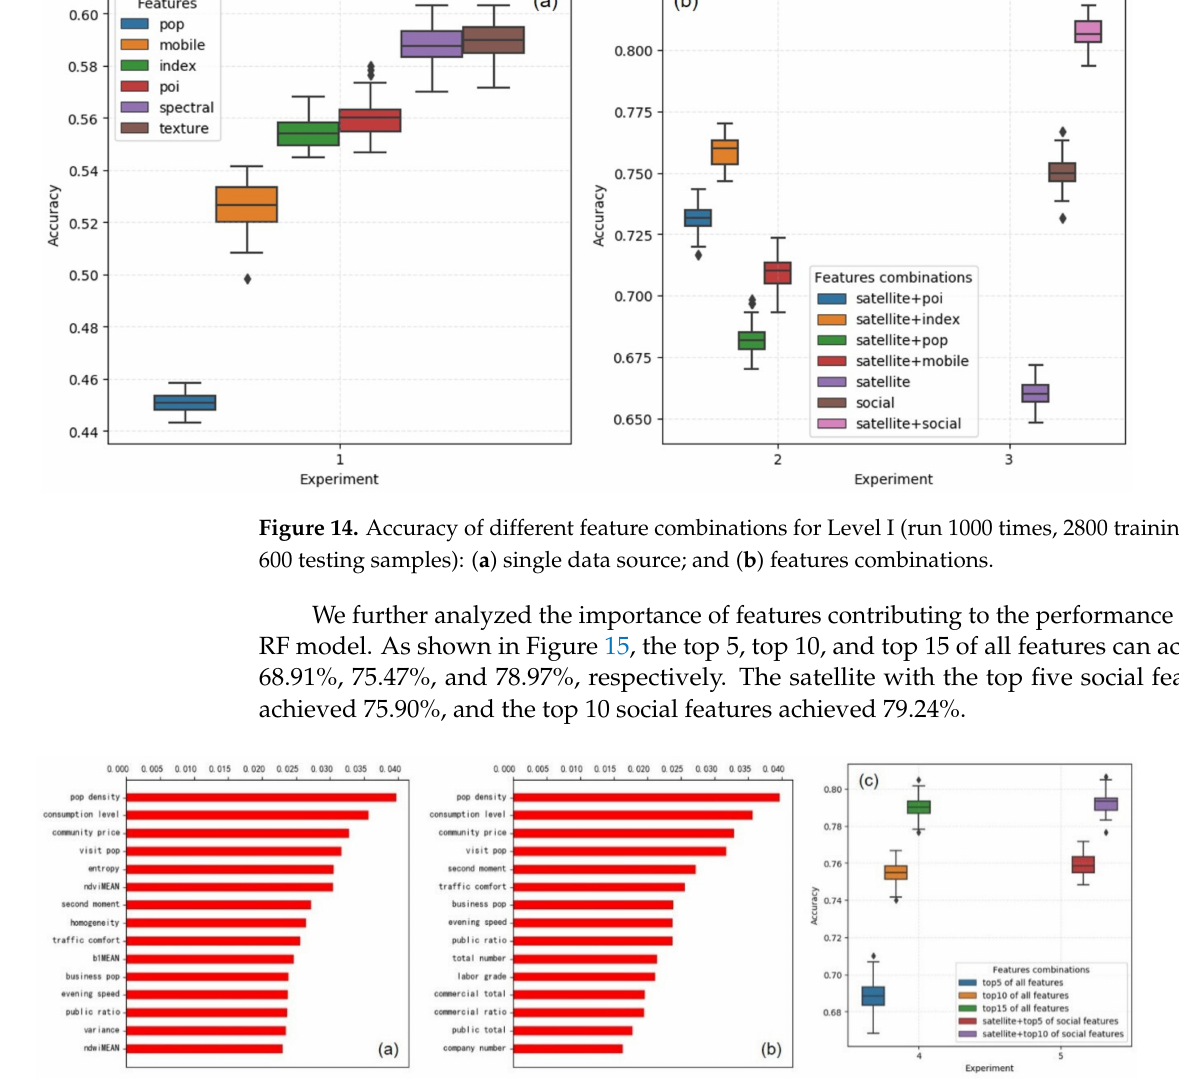
Figure 15. Features importance and contributions for RF model (run 1000 times, 2800 train- ing and 600 testing samples): ( a ) all features importance; ( b ) social features importance; and ( c ) features combinations. The confusion matrix results are as follows.